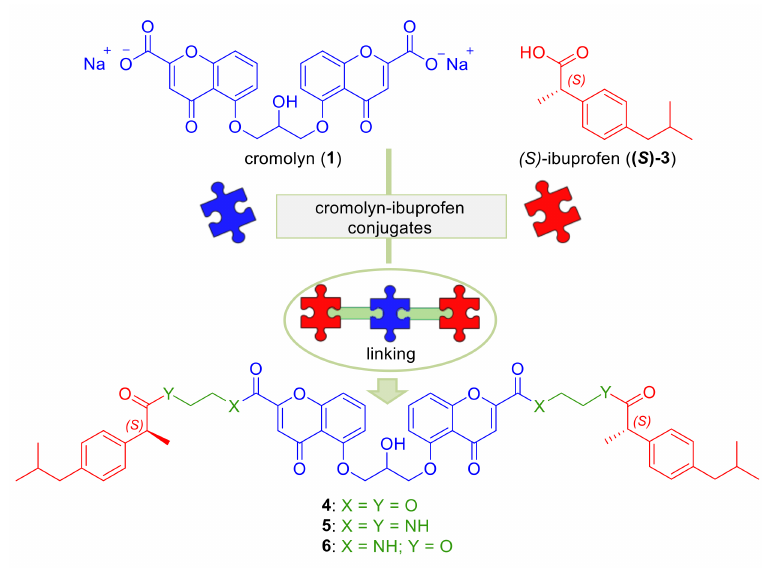
Figure 2. Rational design of novel cromolyn-( S )-ibuprofen conjugates ( 4 – 6